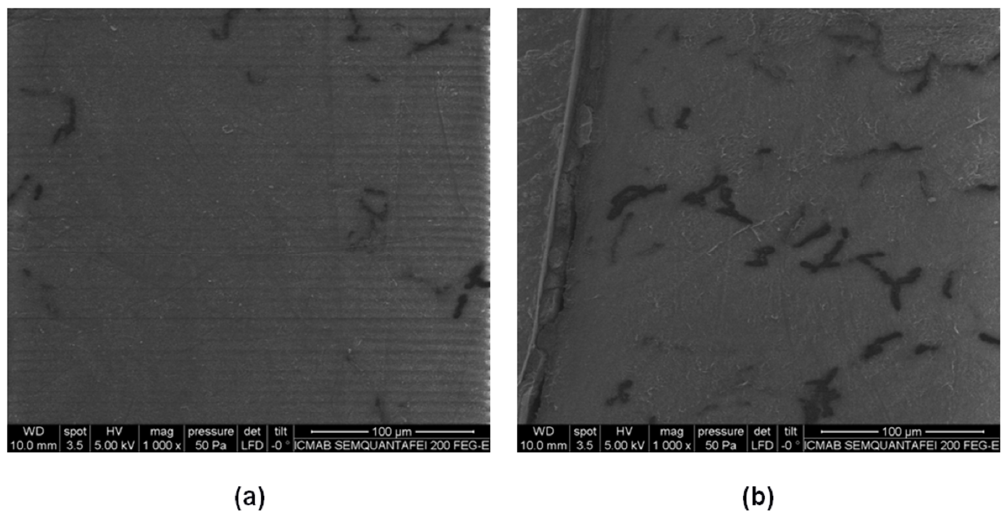
Figure 4. ( a ) SEM in XY orientation, ( b ) and YZ orientation.